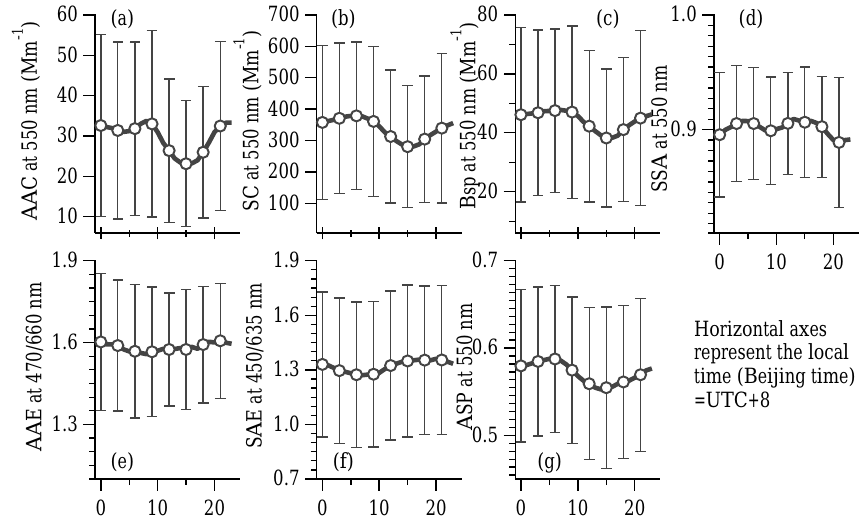
Figure 3. Diurnal variations of 550nm AAC ( a , Mm − 1 ), SC ( b , Mm − 1 ), Bsp ( c , Mm − 1 ), SSA (d) , ASP (g) , 470 / 660nm AAE (e) and 450 / 635nm SAE (f) during the study period.